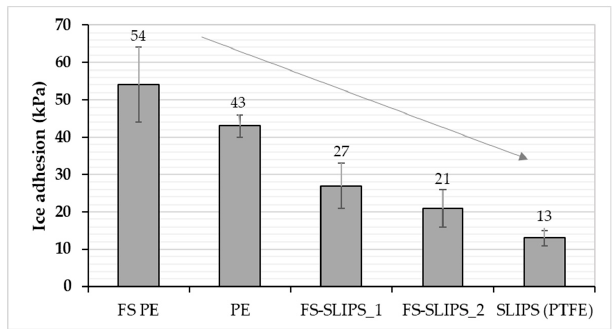
Figure 8. Comparison of ice adhesion between polished FS PE, polished bulk PE, FS-SLIPS and reference SLIPS (PTFE memb + sil.oil ).